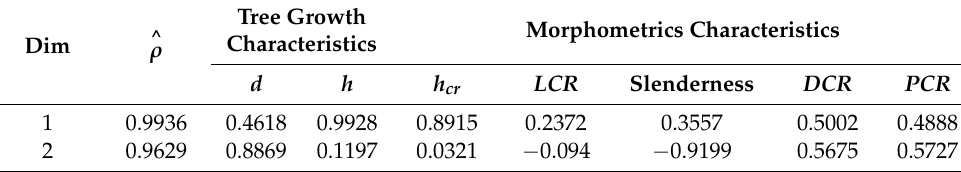
Table 2. The canonical correlation between the tree growth and morphometric characteristics, and the correlations of the variables to the canonical correlation ( n = 50). Tree Growth Morphometrics Characteristics Characteristics Dim ^ ρ d h h cr LCR Slenderness DCR PCR 1 0.9936 0.4618 0.9928 0.8915